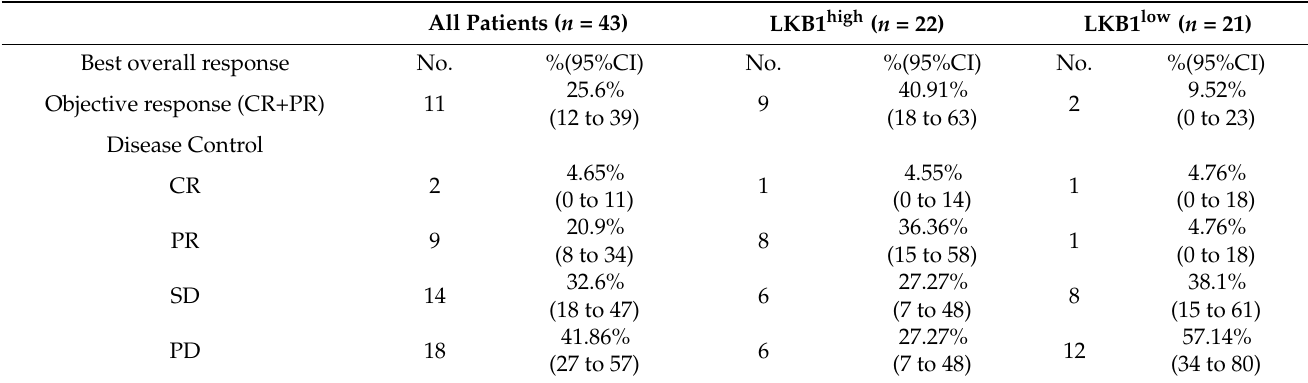
Table 3. Objective gastric cancer patient response to pembrolizumab.